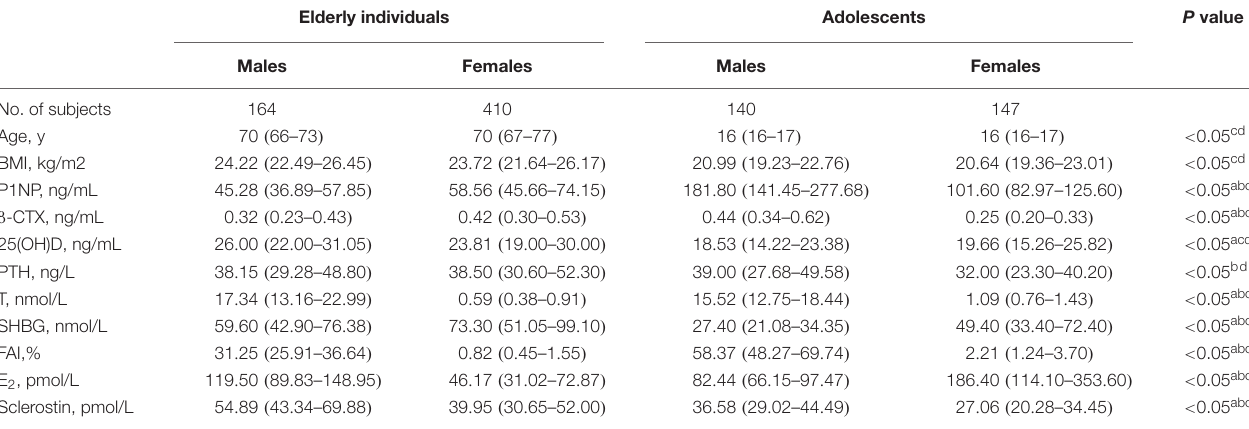
TABLE 1 | Basic characteristics of the 861 participants.